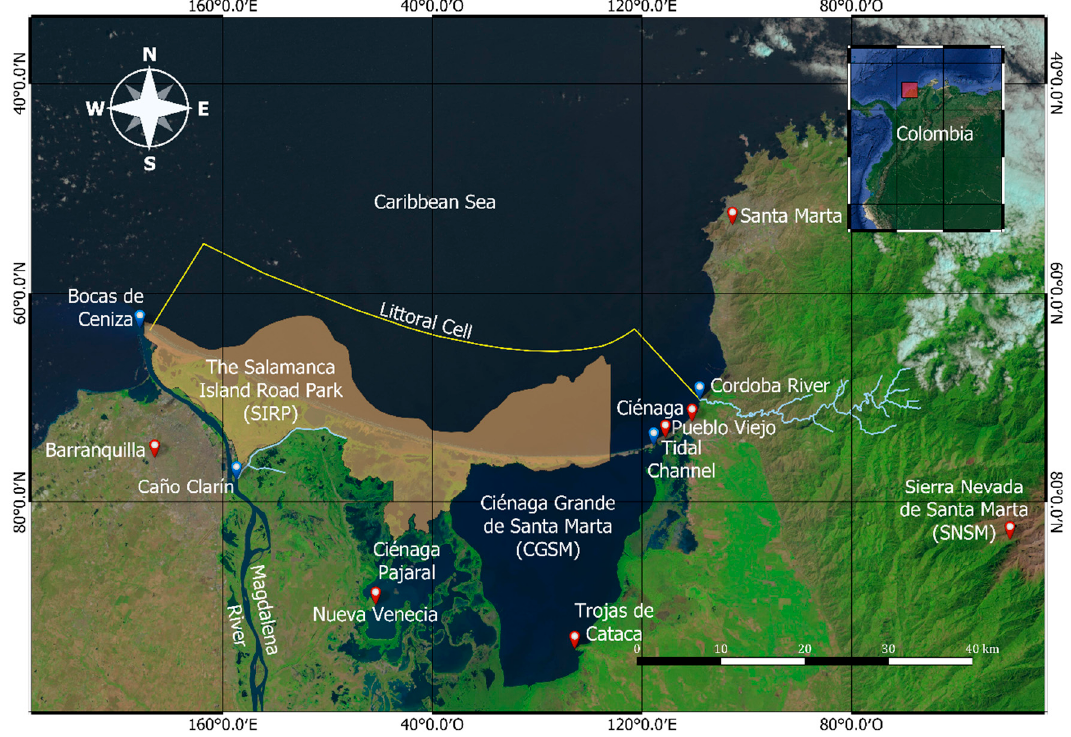
Figure 1. Ciénaga Grande de Santa Marta lagoon complex. Figure 1. Ci é naga Grande de Santa Marta lagoon